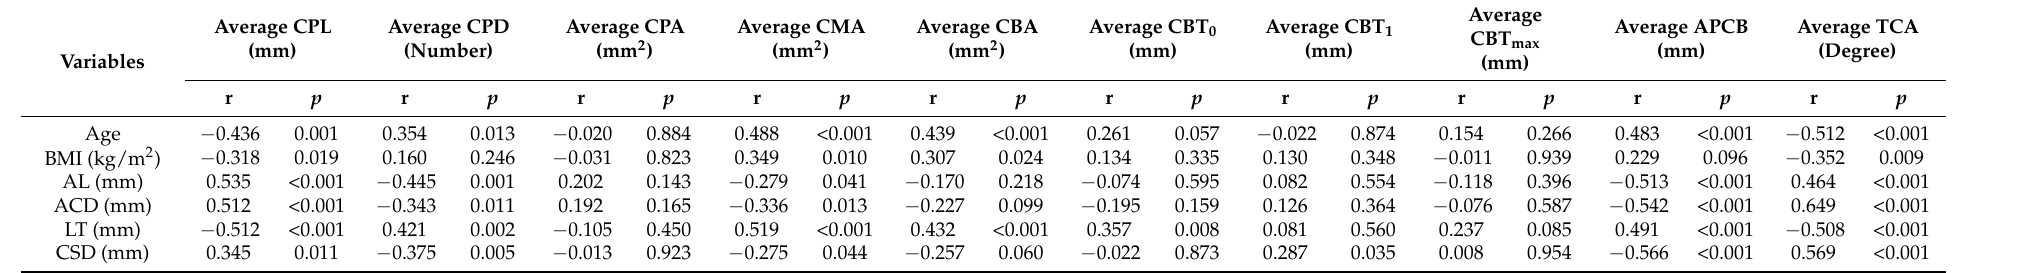
Table 4. Correlations between ciliary process, CB parameters, and systemic and ocular